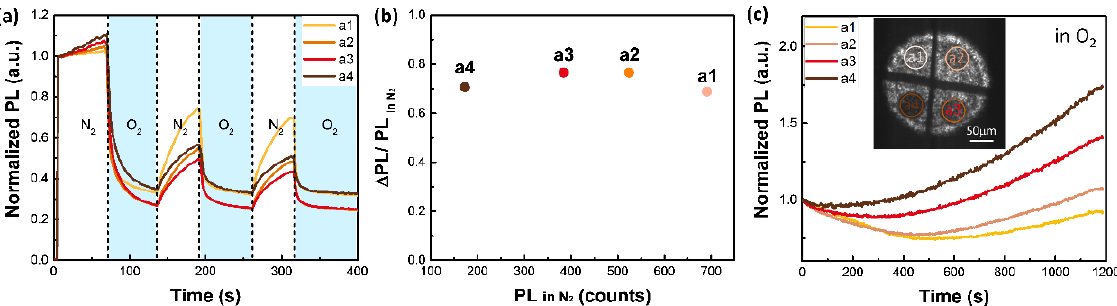
Figure 4. ( a ) PL-quenching effect and ( c ) PL-enhancement effect of O 2 in the four BQ-treated areas with gradually increasing surface defect densities from the first to the fourth area; ( b ) PL-quenching efficiency of O 2 in four areas on the same sample extracted from the data in Panel a. The PL level gradually decreased from the first area to the fourth area.